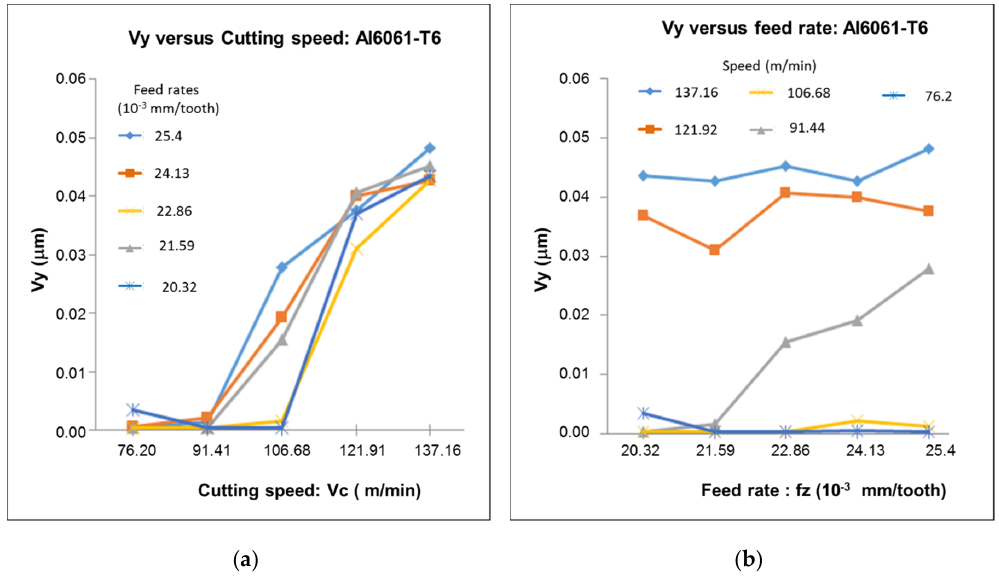
Figure 15. Evolution of the vibration as a function of the variation of ( a ) cutting speed and ( b ) feed rate for the Al6061-T6 alloy.